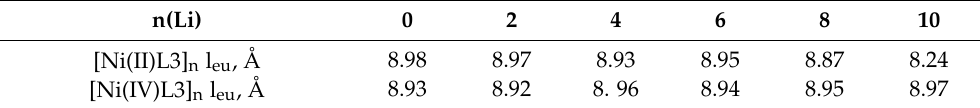
Table 4. Repeating unit length (l eu ) of the polymers with L3 upon lithiation.